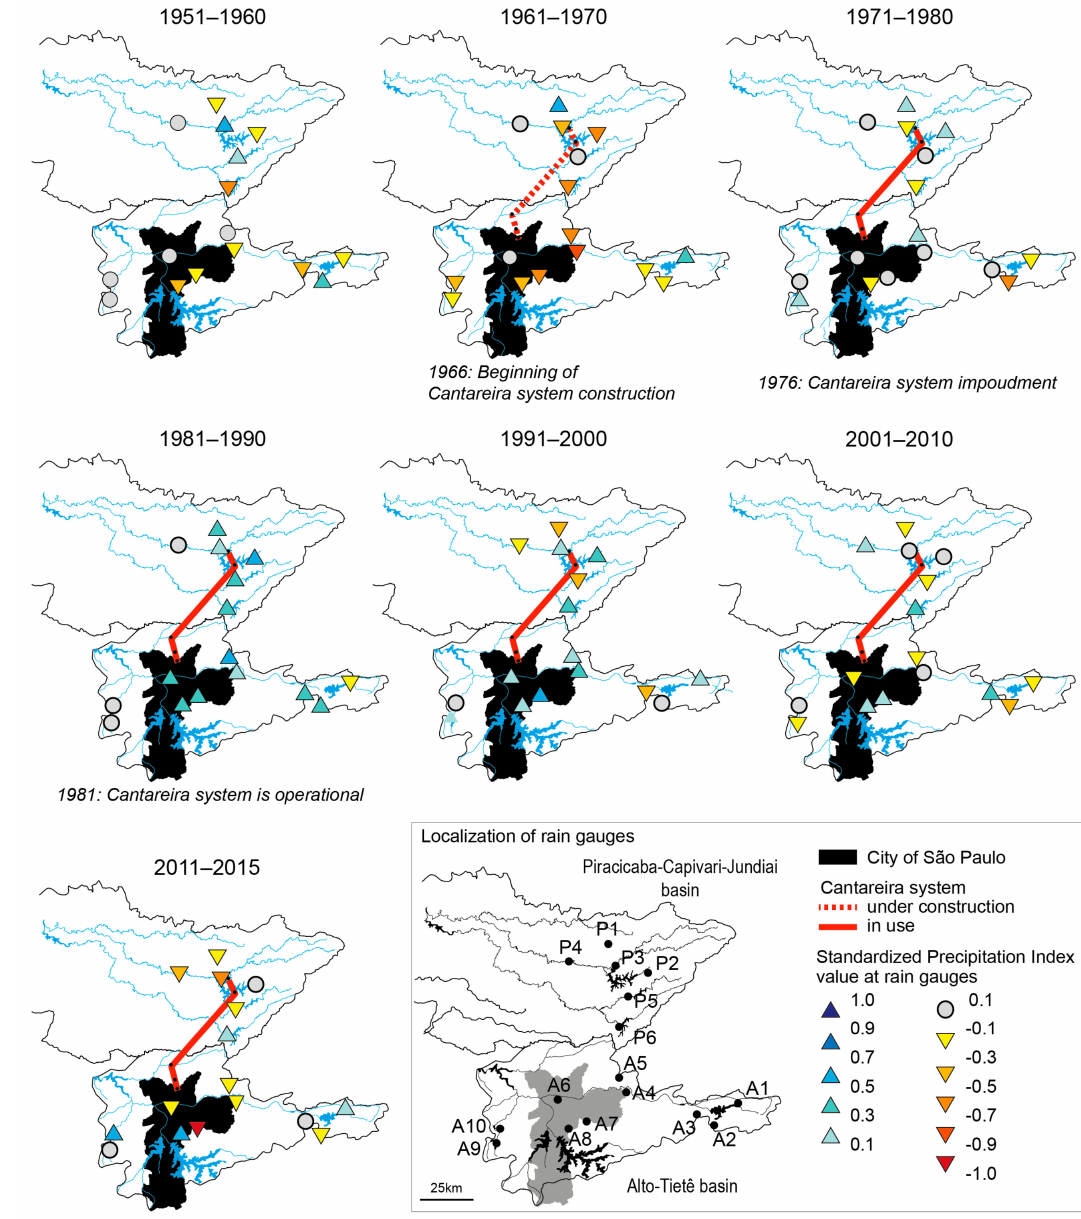
Figure 5. Decadal standardized precipitation index (SPI) based on annual SPI values computed for each rain gauges of the Alto-Tiet ê basin and the headwaters of the PCJ basin for the 1951–2015